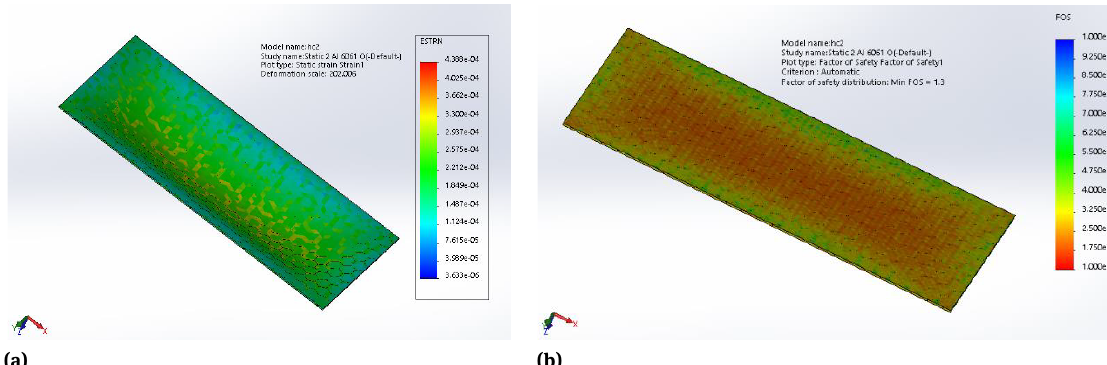
Figure 12: Results for the general honeycomb: (a) Strain and (b) safety factor